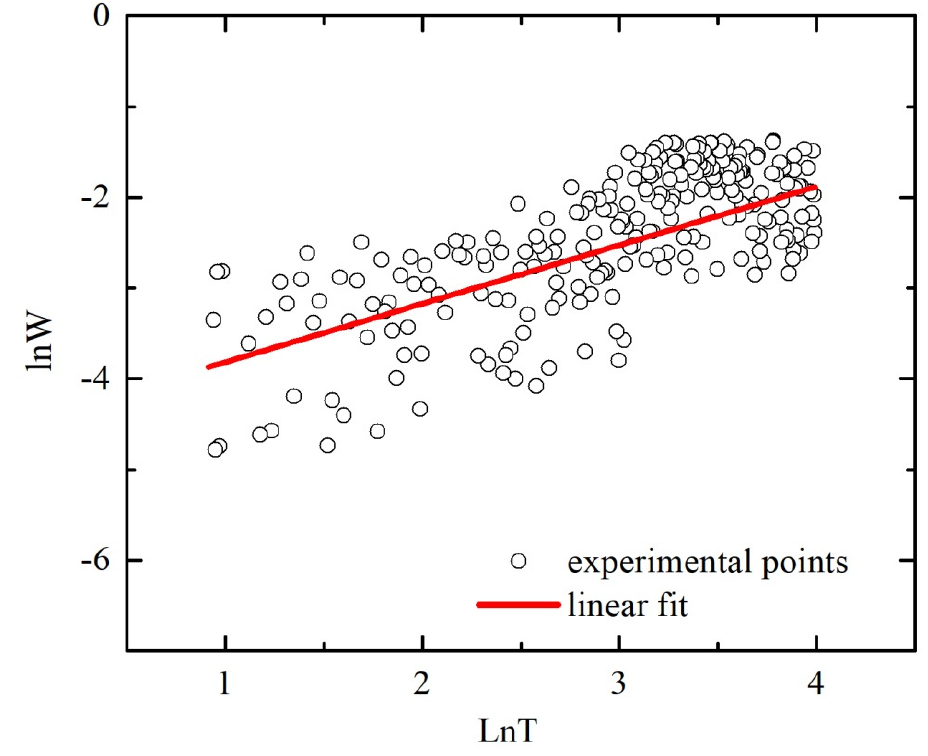
Figure 5. Plot ln W versus ln T for polycrystalline SnO 2 − δ film deposited by reactive magnetron sputtering of tin on glass with the following annealing in air at 375 °C (sample B).